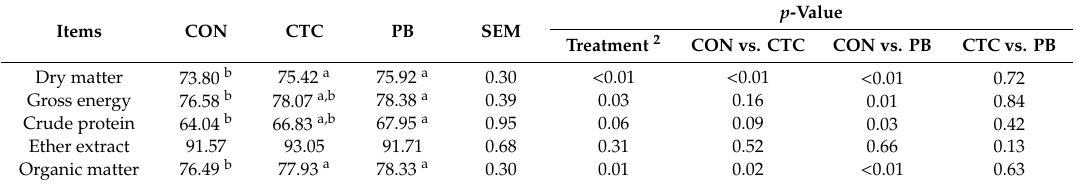
Table 4. E ff ects of probiotics on the nutrient retention of broilers (%, day 42) 1